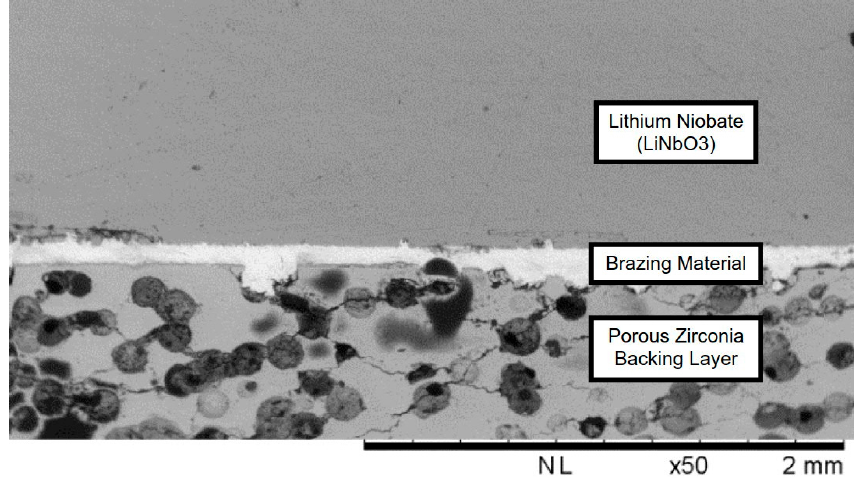
Figure 3. SEM sectioned view of lithium niobate (LiNbO 3 ) brazed to porous zirconia with a reduced ramp rate.